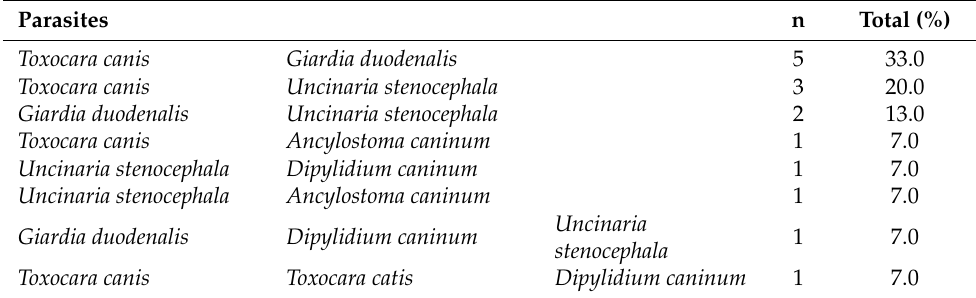
Table 2. Co-infections of playground zoonotic